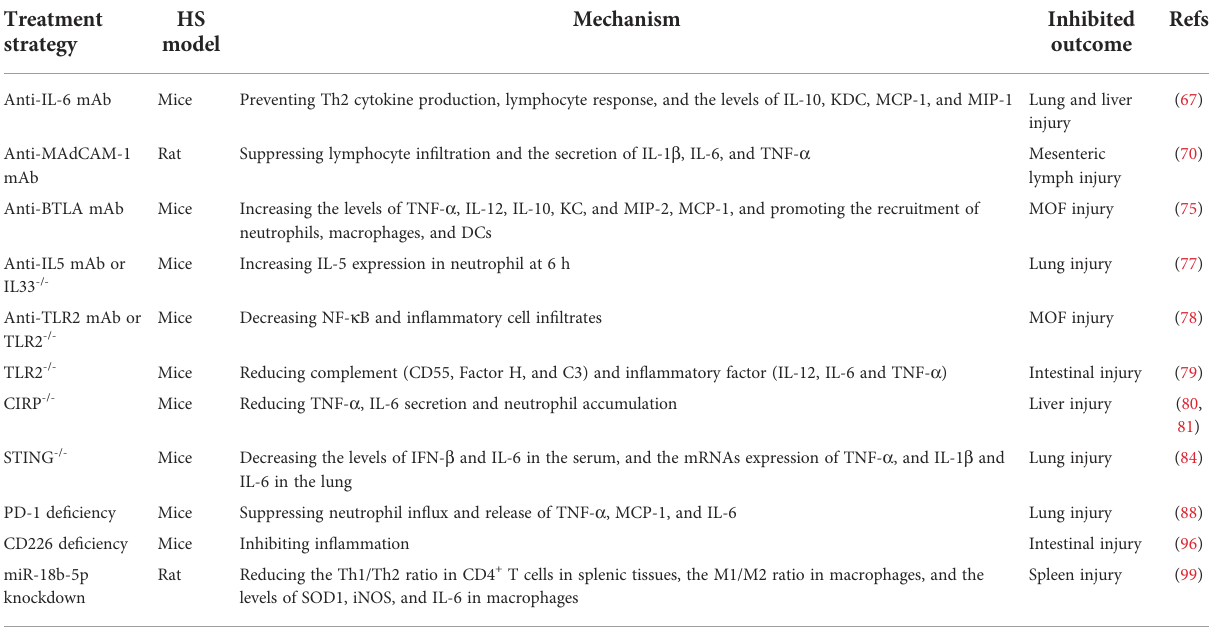
TABLE 2 Summary of the applications of antibody therapy and genetic approaches in the hemorrhagic shock model. Treatment